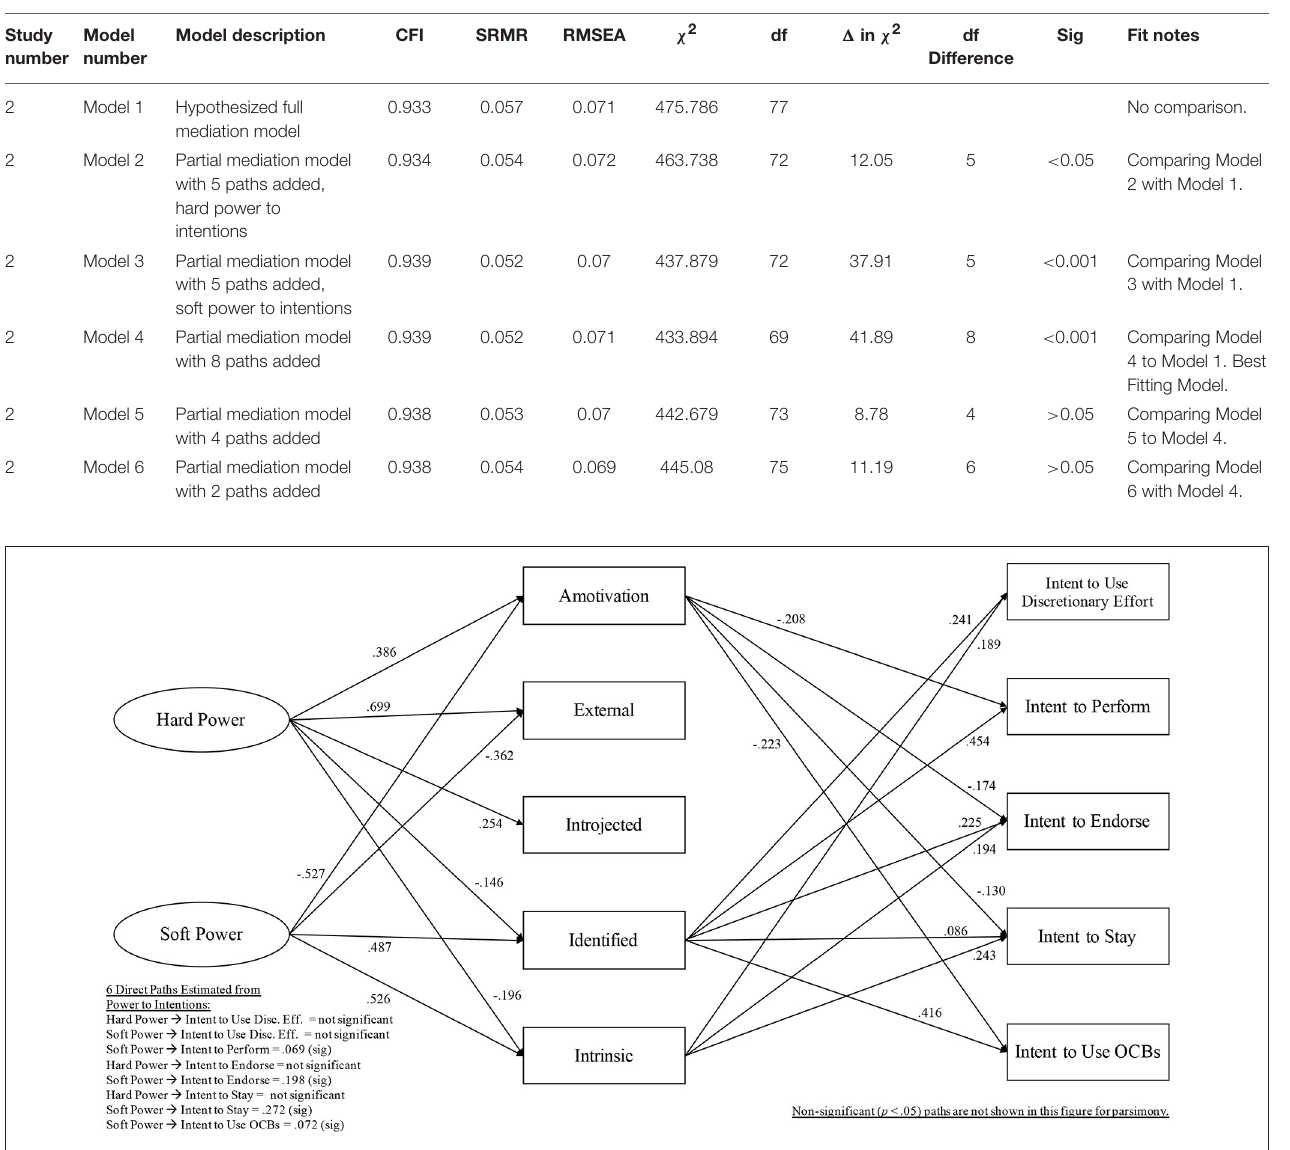
followers working under leaders who used soft power